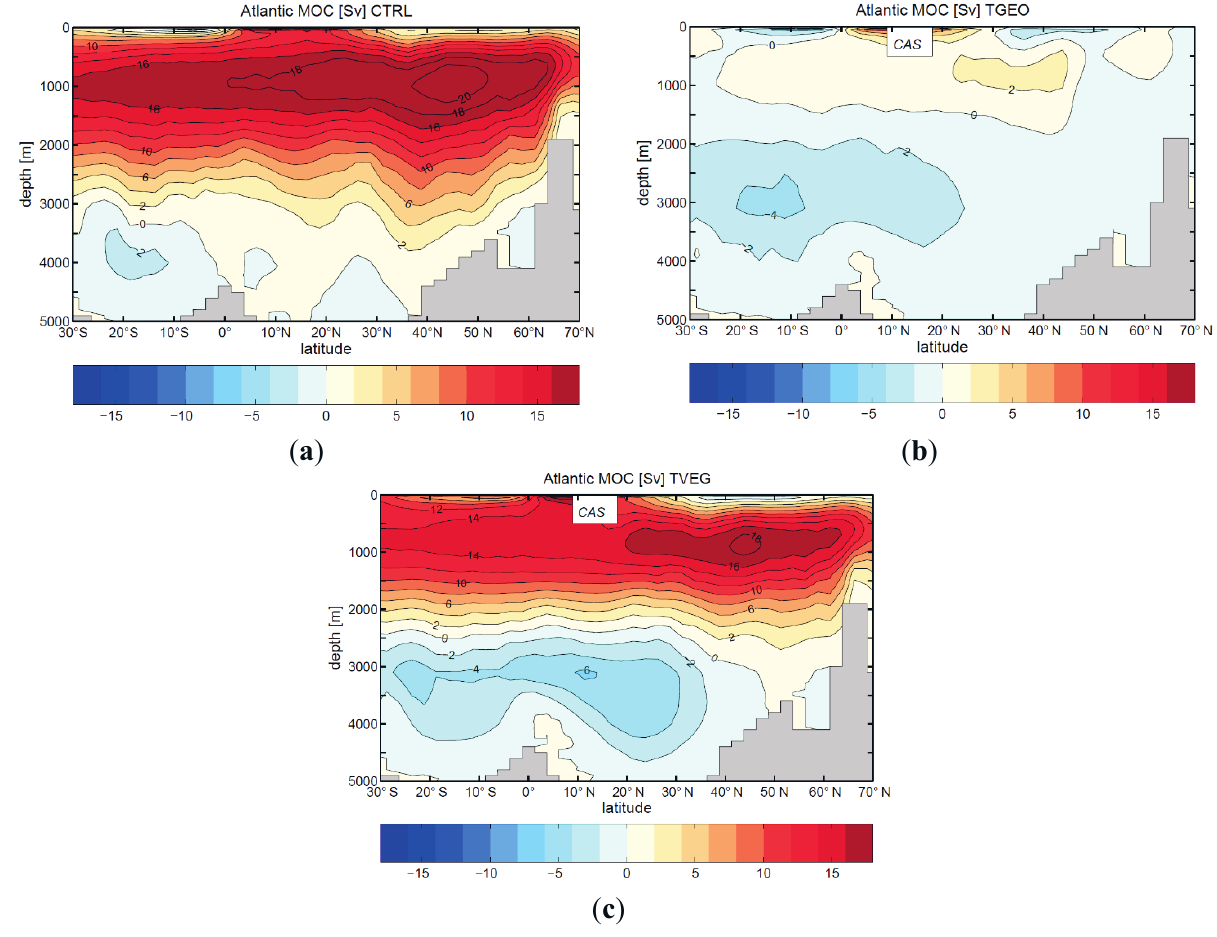
Figure 8. Atlantic meridional overturning circulation (Sv = 10 6 m 3 /s) for present-day ( a ), and the late Miocene configuration with open Central American Seaway (CAS); ( b ) with present vegetation cover (TGEO); and ( c ) with reconstructed vegetation cover